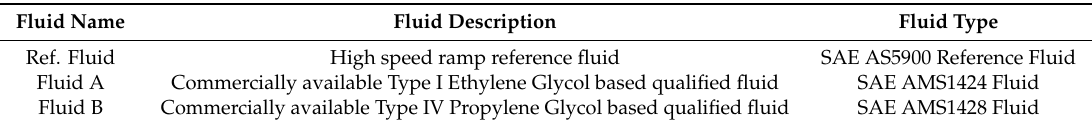
Table 1. Fluids description.